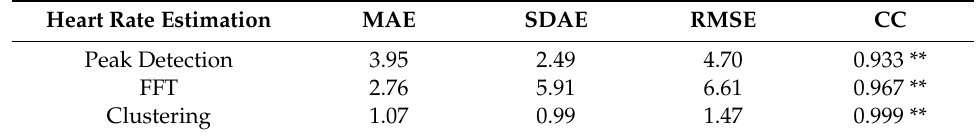
Table 2. Estimation of heart rates from the normal dataset without facial expressions and voluntary head motions.